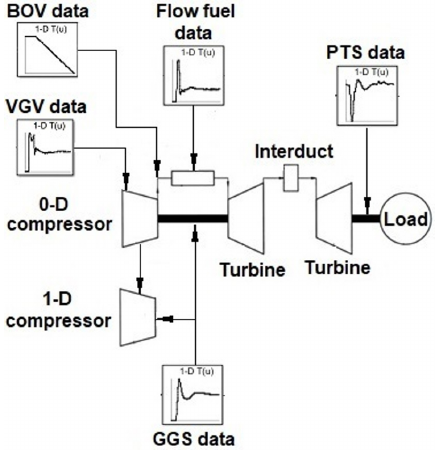
Figure 7. Overall modeling architecture for dynamic simulation of compressor performance.